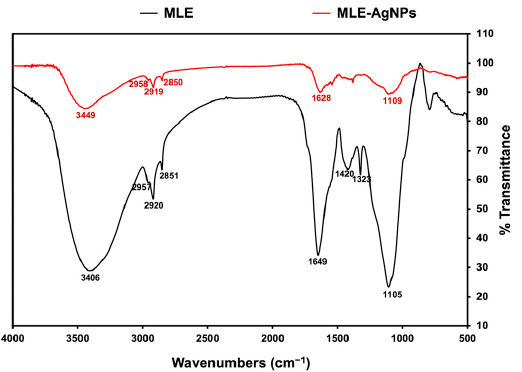
Figure 3. FTIR spectrum of MLE (black) and MLE-AgNPs (red).